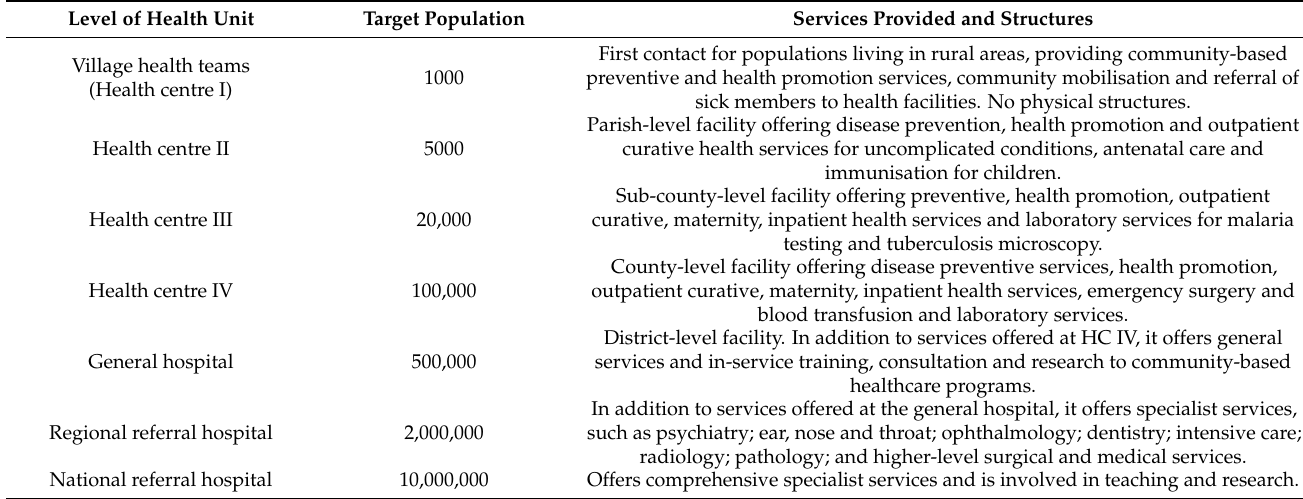
Table 1. The health facility classification in